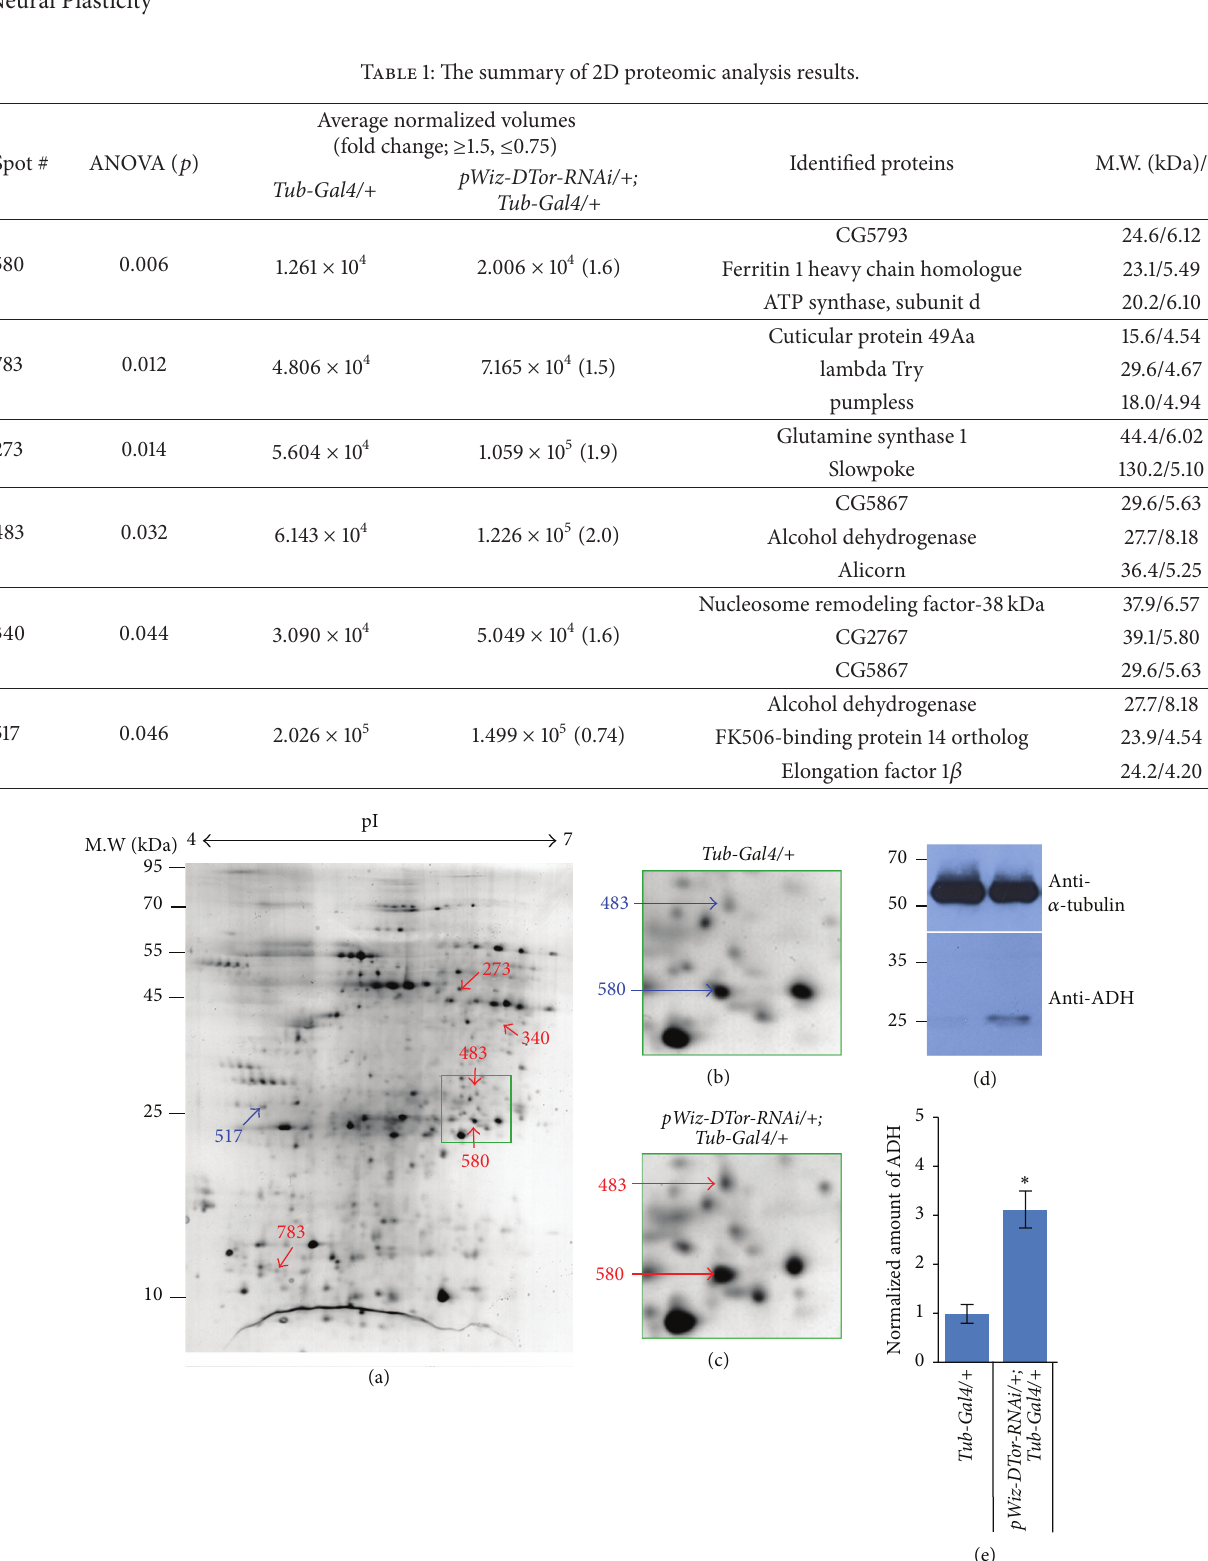
Figure 6: 2D analysis of proteins extracted from Drosophila adult heads. (a) Representative 2D electrophoresis image of protein extracts from control adult heads. A total of 6 spots were dysregulated in DTor-RNAi expressing fly brains. Blue arrows indicated spots with decreased volumes in DTor-RNAi expressing flies compared with controls. Red arrows point to spots with increased volumes in DTor-RNAi-expressing flies compared with controls. (b) Spots 483 and 580 in a control gel. (c) Spots 483 and 580 in a DTor-RNAi gel showing a comparatively larger volume. (d) Anti-ADH western blot analysis of genetic back ground and DTor-RNAi-expressing flies. (e) ADH protein levels detected from protein extracts from DTor-RNAi-expressing flies were 3.1-fold of those of control fly brains. ∗ 𝑝 <